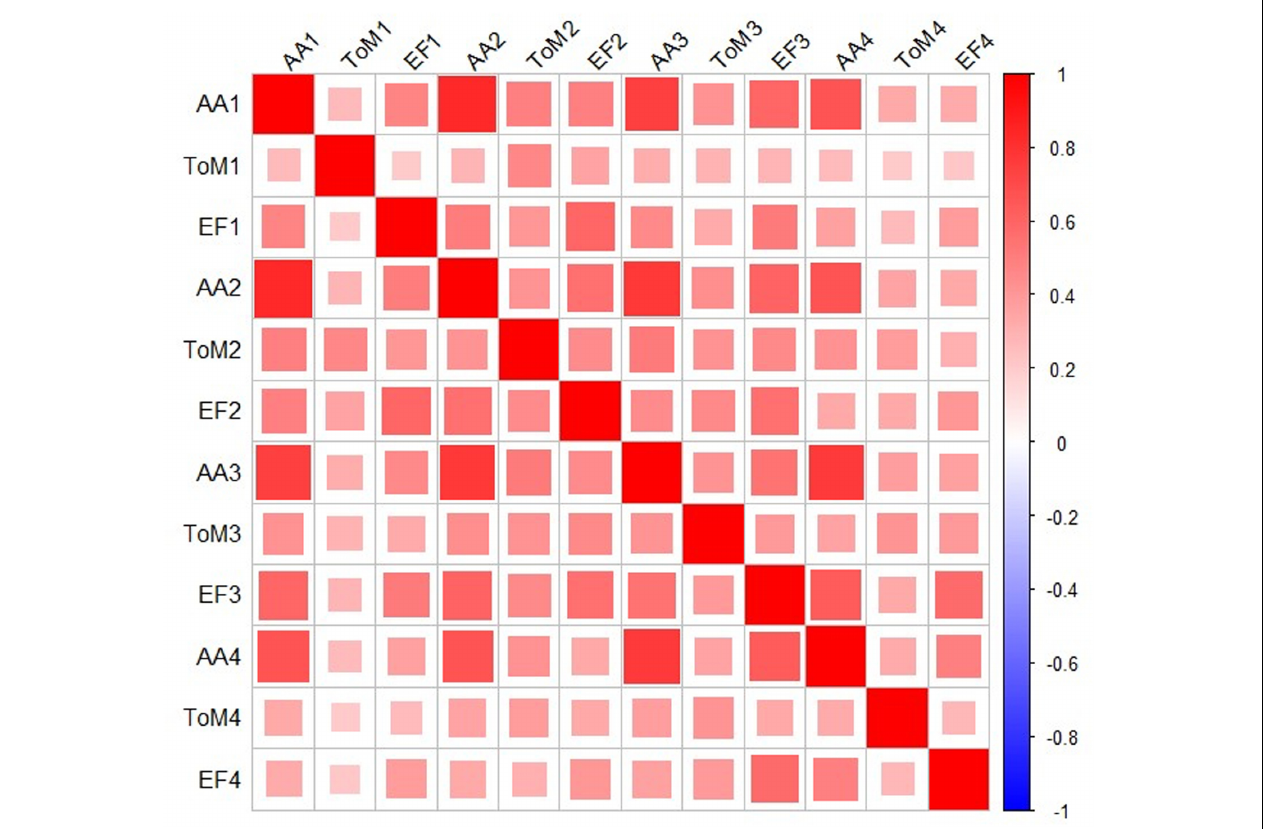
FIGURE 1 | Correlation Table for Academic Achievement, Theory of Mind, and Executive Function across four time points. These variables were selected because their interrelations are of significant interest in preschool research. In this graphic representation, all squares are red because all correlations were positive. The shading legend is on the right. Darker colors (as well as larger squares) represent stronger